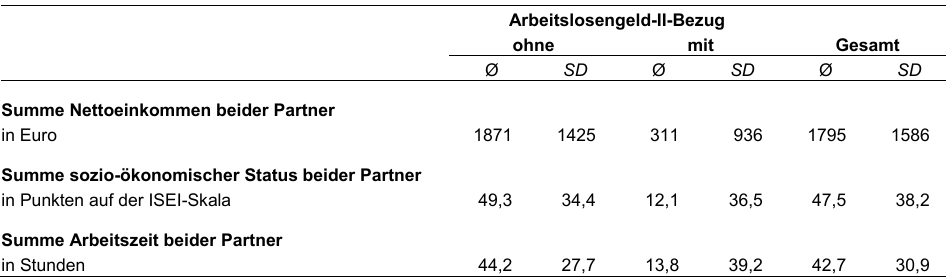
Tabelle 7: Beschreibung des Analysesamples (dyadische Paarebene nach Arbeitslosengeld-II-Bezug, metrische